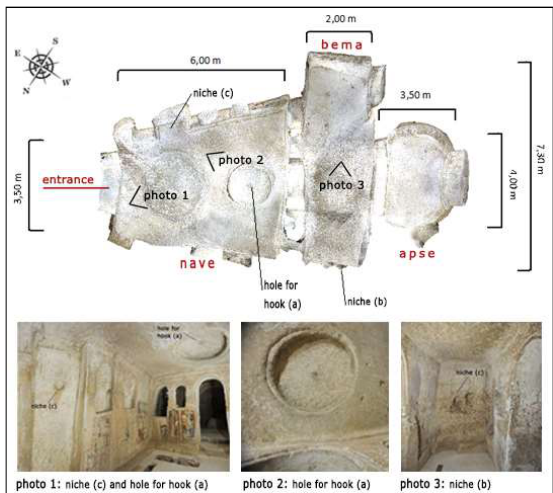
Figure 4: Agisoft Photoscan Sw. View of texturing model with the indications about niches and hole for hook.